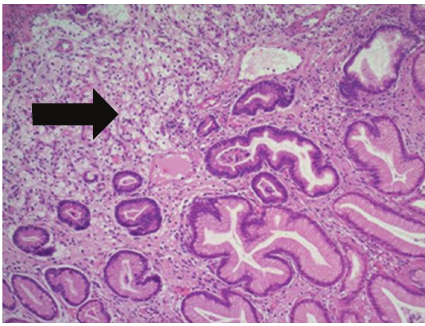
Figure 2: Microscopy of gastric nodule.